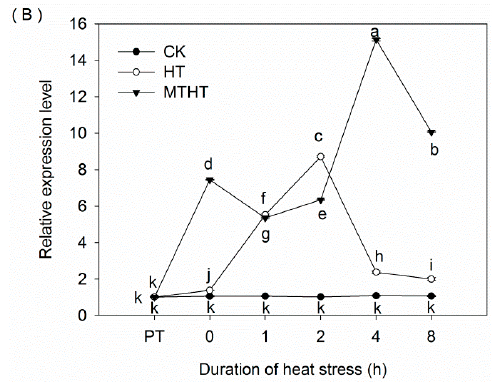
Figure 5. ( A ) Results of RNA-seq showing significant differences in GST gene expression between MTHT and HT; ( B ) Data from qRT-PCR showing GST25 ( ACHN160841 expression profile under heat stress. Lowercase letters indicate significant differences ( p < 0.05).